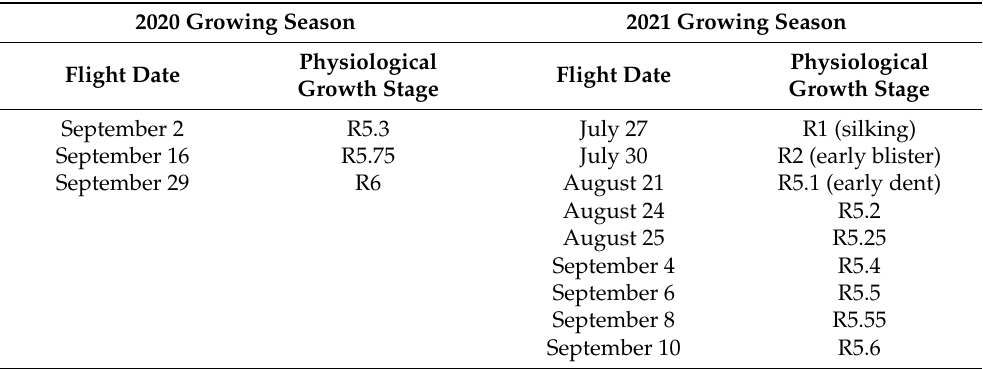
Table 3. UAS flight dates and associated maize physiological growth stages during 2020 and 2021 growing seasons.